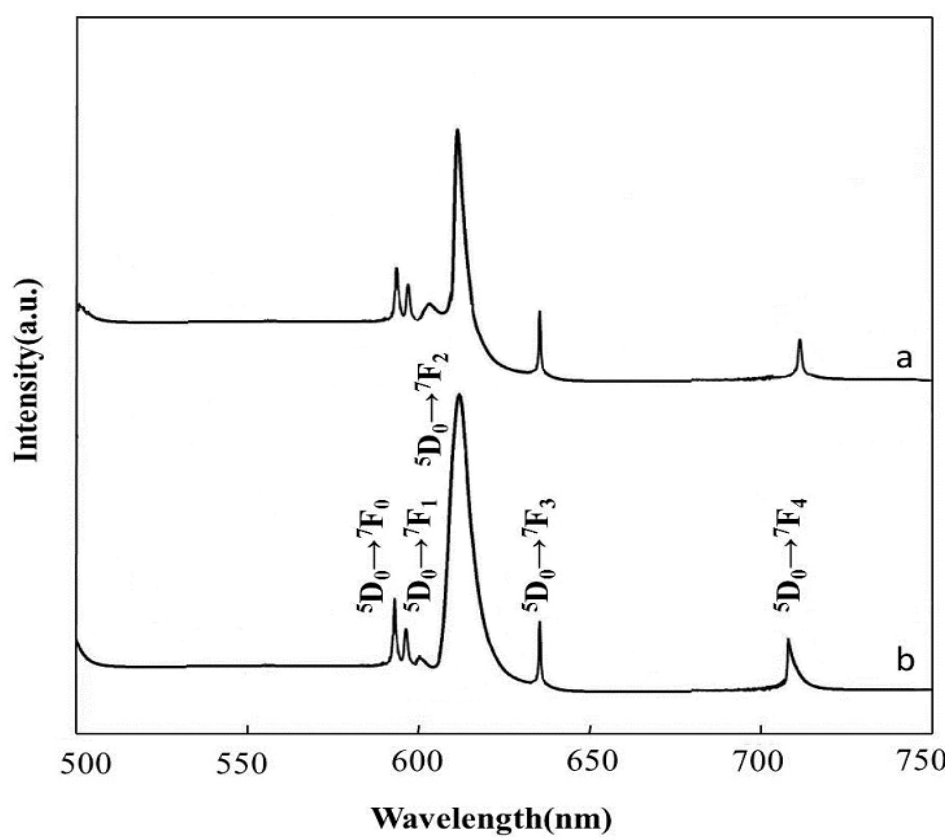
Figure 7. The PL spectra of ( a ) diatom coated with 6% Eu-doped Y 2 O 3 and ( b ) 8% Eu-doped Y 2 O 3 . Adsorption/desorption isotherm of nitrogen for uncoated diatomite and coated with 6% Eu 3+ -substituted Y 2 O 3 are shown in Figure 8. In the case of both specimens, two isotherms with obvious hysteresis loop were noticed in the pressure range of 0.3–1.0 p/p 0 . The BET specific surface area of biosilica is 1.5 m 2 /g. Additionally, the BET specific surface area of diatomite coated with 6% Eu-substituted Y 2 O 3 (8.7 m 2 /g) considerably exceeds that of uncoated diatom. A superior adsorption performance is expected for coated-diatom with europium-doped Y 2 O 3 nanoparticles.